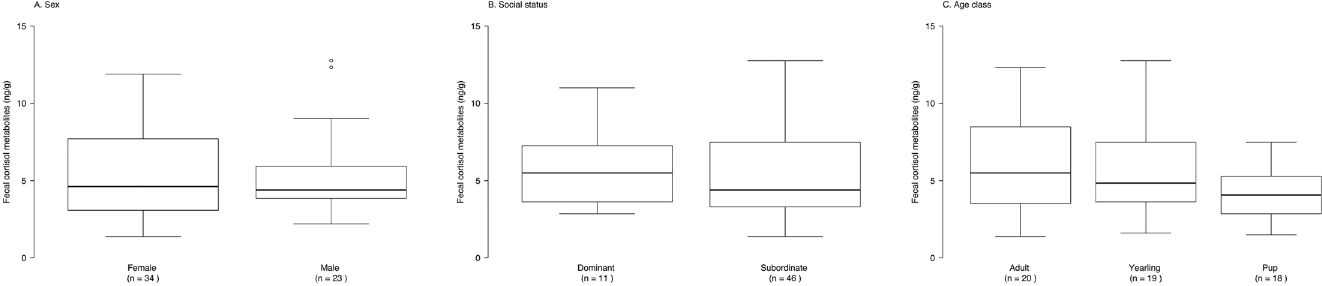
Fig 1. Concentrations of fecal cortisol metabolites in two wolf packs from Yellowstone National Park (USA), 2007 – 2009, grouped by (a) sex, (b) social status, and (c) age-class. Box and whisker plots show median (horizontal line within box), 25% and 75% percentiles (box), range (whiskers) and statistical outliers (open circles). For clarity, FCM values above 15 ng/g are not shown.